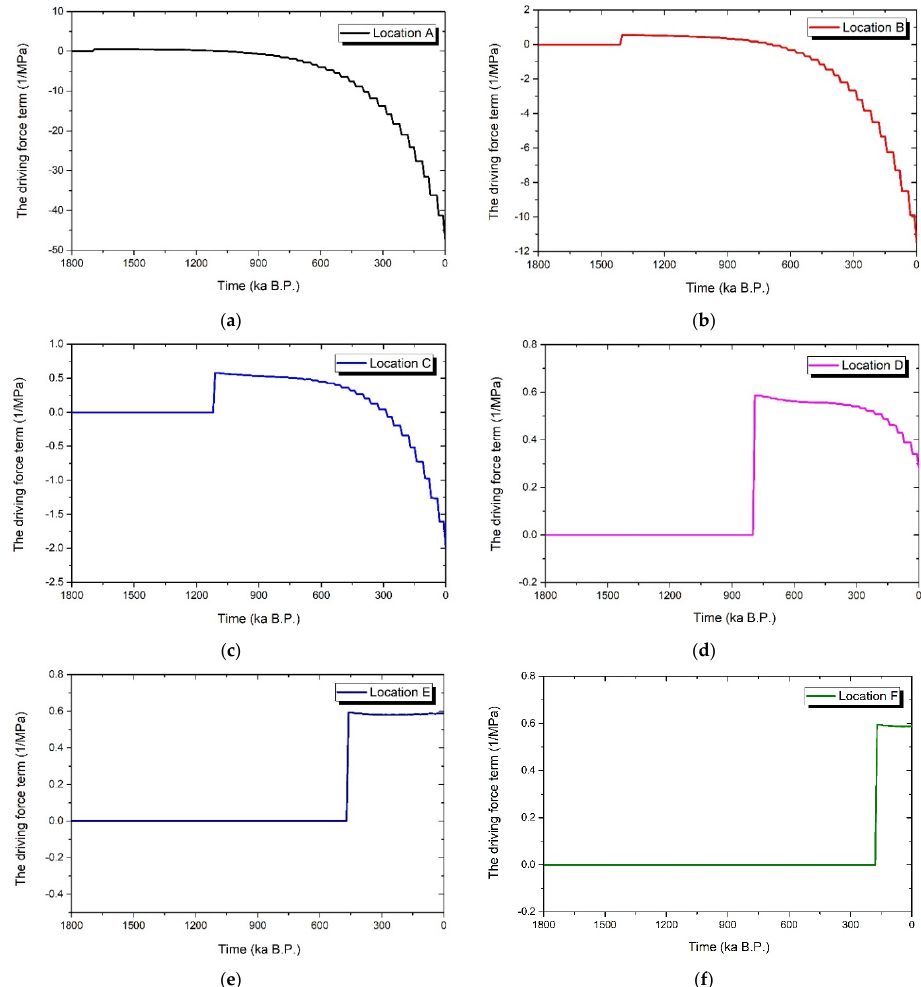
Figure 12. The reaction term, r h / ζ 0 , evolves over time at six selected slope locations.